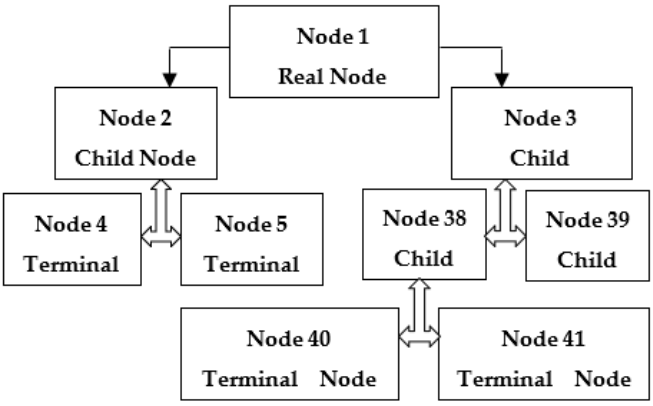
Figure 2. Flow sheet diagram of decision tree forests.